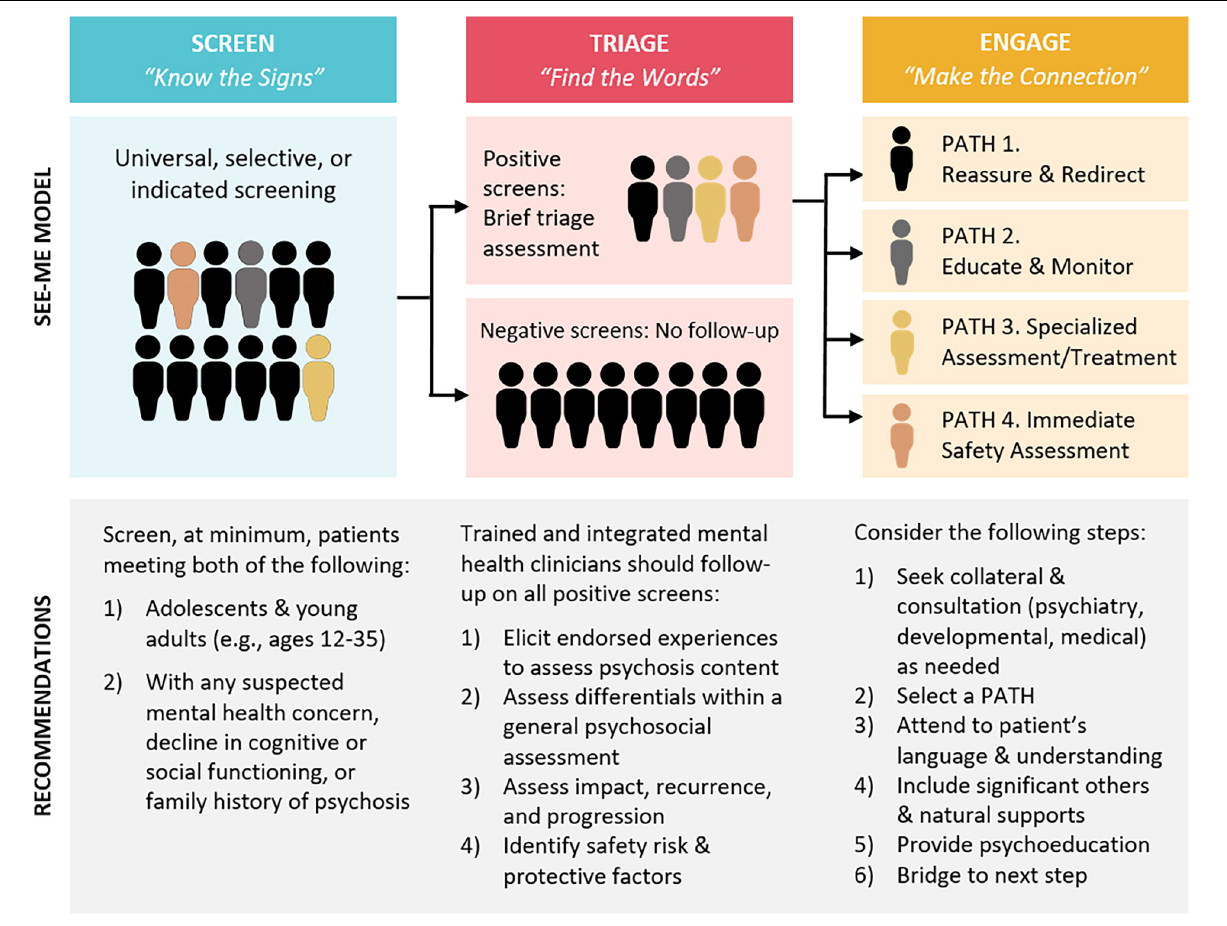
FIGURE 2 | SEE ME